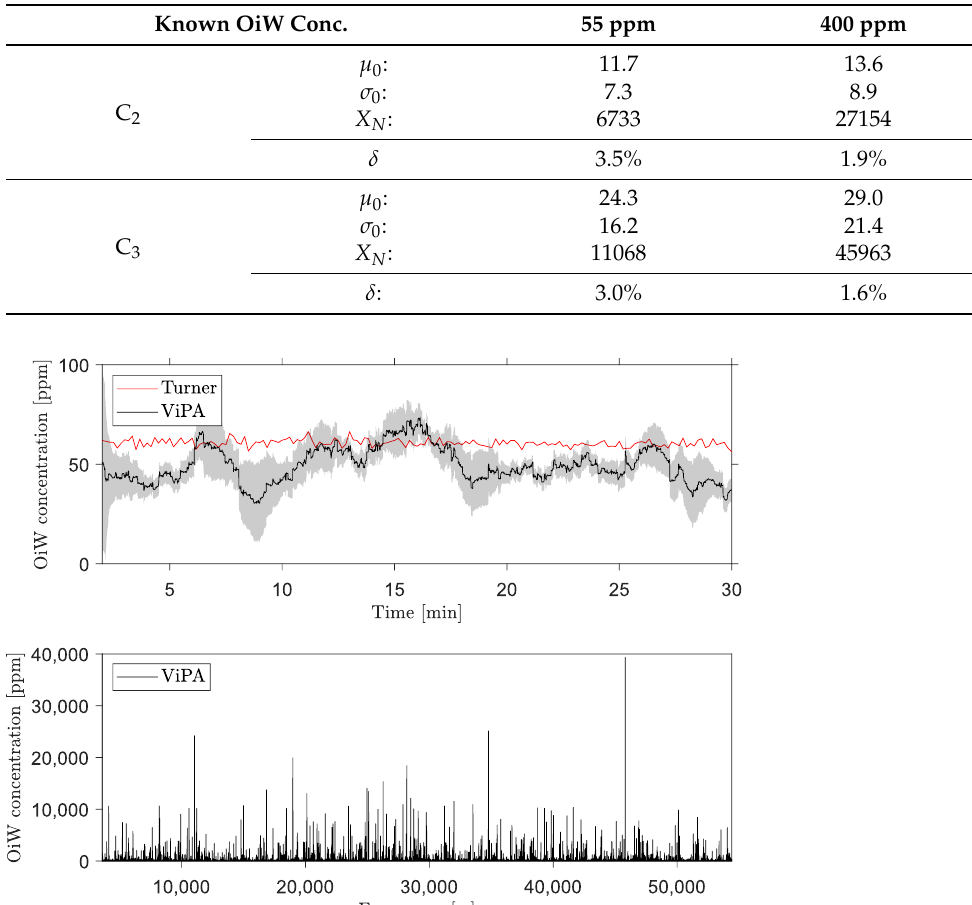
Figure 15. Droplet size distribution obtained with C 3 based on the measured OiW concentrations at the known concentration of 55 ppm and 400 ppm, respectively. Table 7. Associated results to Figures 14 and 15, calculating the δ , related to each PSD of each OiW concentration measured with C 2 and C 3 .